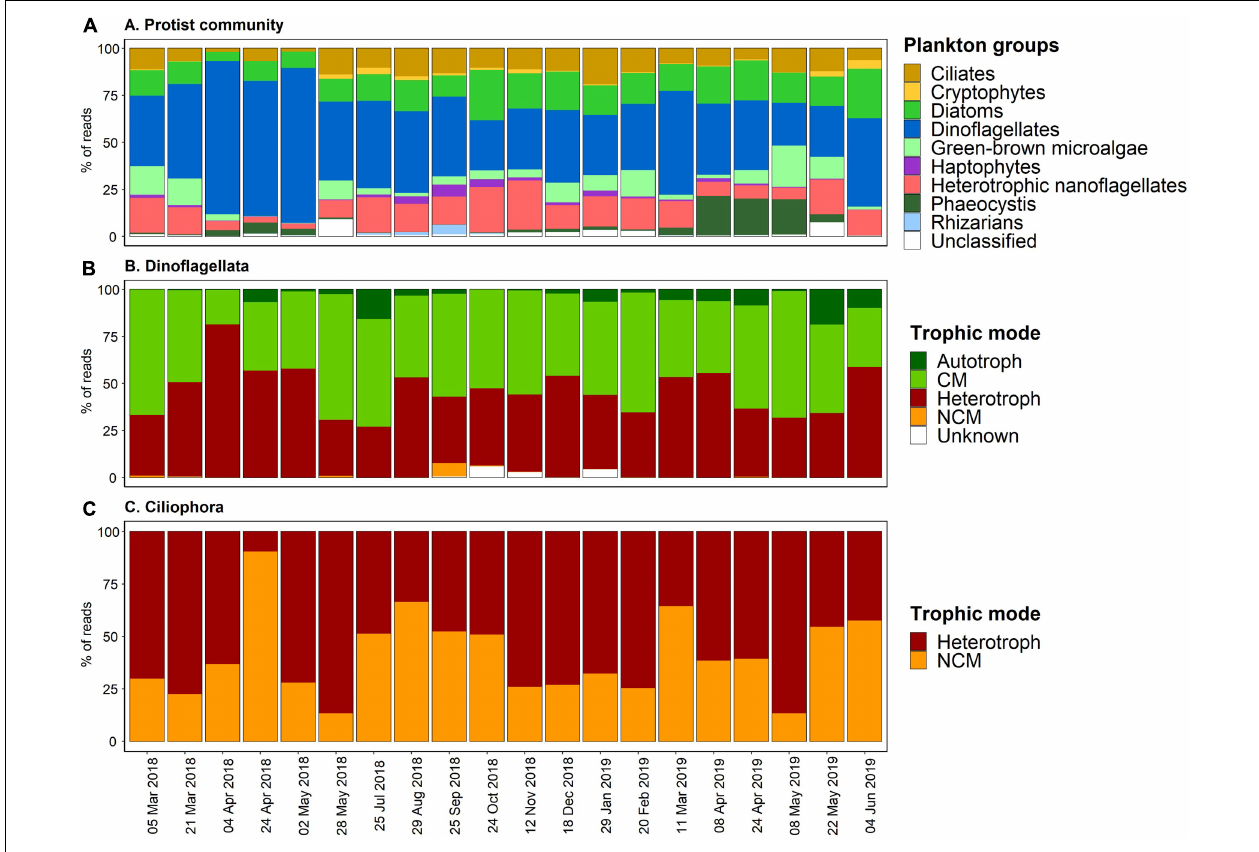
FIGURE 4 | (A) Temporal succession of the BCZ metabarcoding survey displaying the proportions of reads of the different taxonomic functional plankton groups across years 2018–2019. (B,C) Display the temporal relative proportions of the trophic modes assigned to Dinoflagellata and Ciliophora,